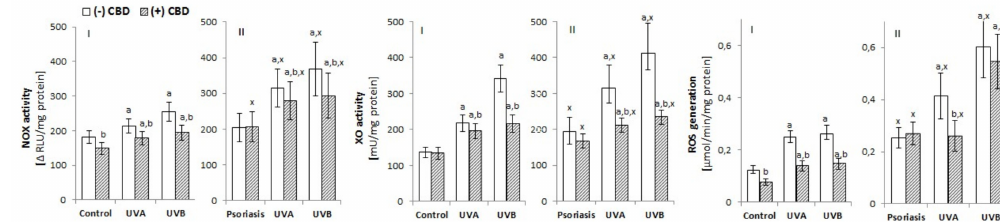
Figure 1. E ff ect of cannabidiol (CBD) (4 µ M) on NADPH oxidase and xanthine oxidase (XO) activity as well as reactive oxygen species (ROS) generation in keratinocytes exposed to UVA (30 J / cm 2 ) and UVB (60 mJ / cm 2 ) radiation. The keratinocytes were obtained from healthy subjects ( I ) (n = 15) and patients with psoriasis vulgaris ( II ) (n = 30). The mean values ± SD are presented with statistically significant di ff erences: a -vs. control / psoriasis group; b -vs. group without CBD; x -psoriasis vs. control groups; p <